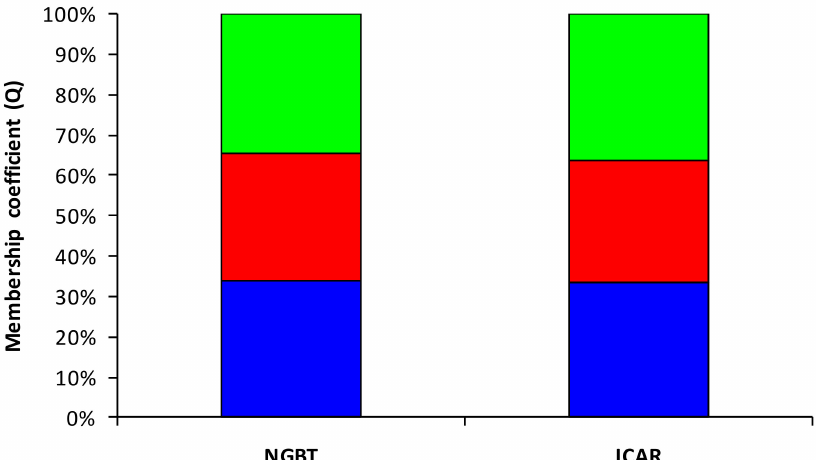
Figure 4. Membership coe ffi cient (Q) mean of the faba bean collection split in samples collected by the National Gene Bank of Tunisia (NGBT) and Agricultural Research in the Dry Areas (ICARDA). The di ff erent colors indicate the three subpopulations detected using a Bayesian approach (blue: subpopulation 1; red: subpopulation 2, and green: subpopulation